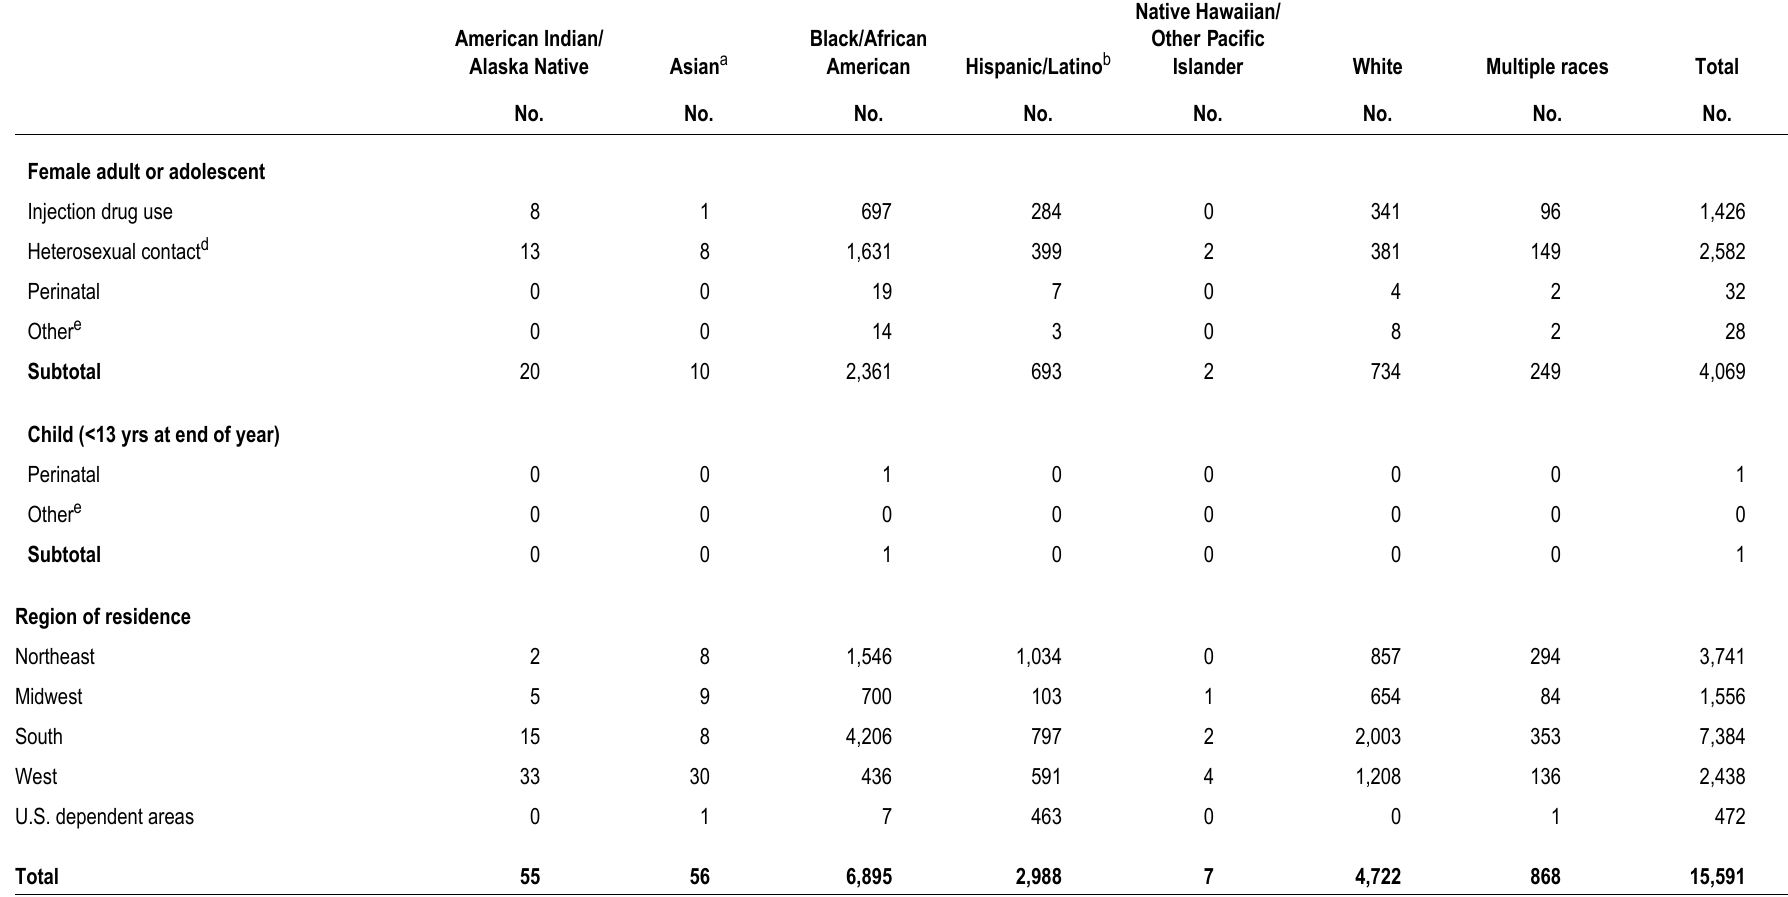
Table 14b. Deaths of persons with diagnosed HIV infection, by race/ethnicity and selected characteristics, 2014—United States and 6 dependent areas